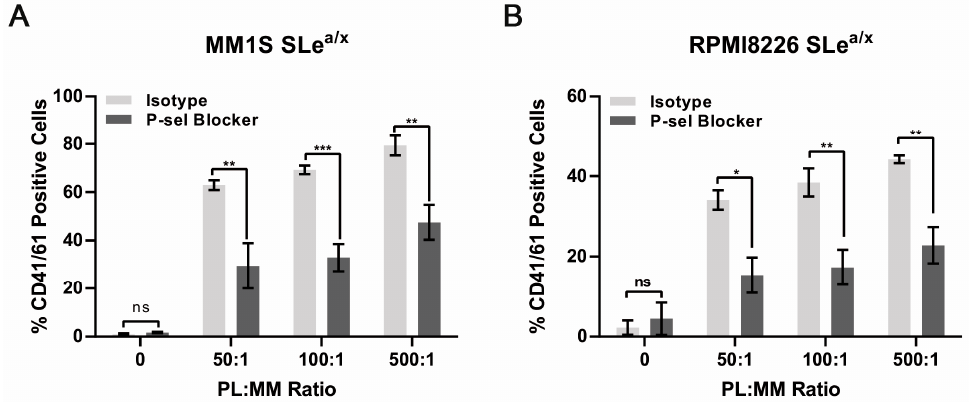
Figure 3. Interactions between SLe a/x -enriched MM cells and platelets are inhibited by an anti-P- selectin blocking antibody. ( A , B ) SLe a/x -enriched MM1S ( A ) and RPMI8226 ( B ) cells were co-cultured with platelets at the indicated platelet:MM ratios for 30 min, washed and then incubated further for 30 min in the presence of an anti-P-selectin blocking antibody or isotype control (both 10 µ g/mL). After incubation, the cells were washed and stained by flow cytometry. Bars represent the mean ± sem of at least three independent experiments. Statistical analysis was performed using two-way ANOVA and Sidak’s multiple comparison test. *** p < 0.001; ** p < 0.01; * p < 0.05; ns non-signif- icant.